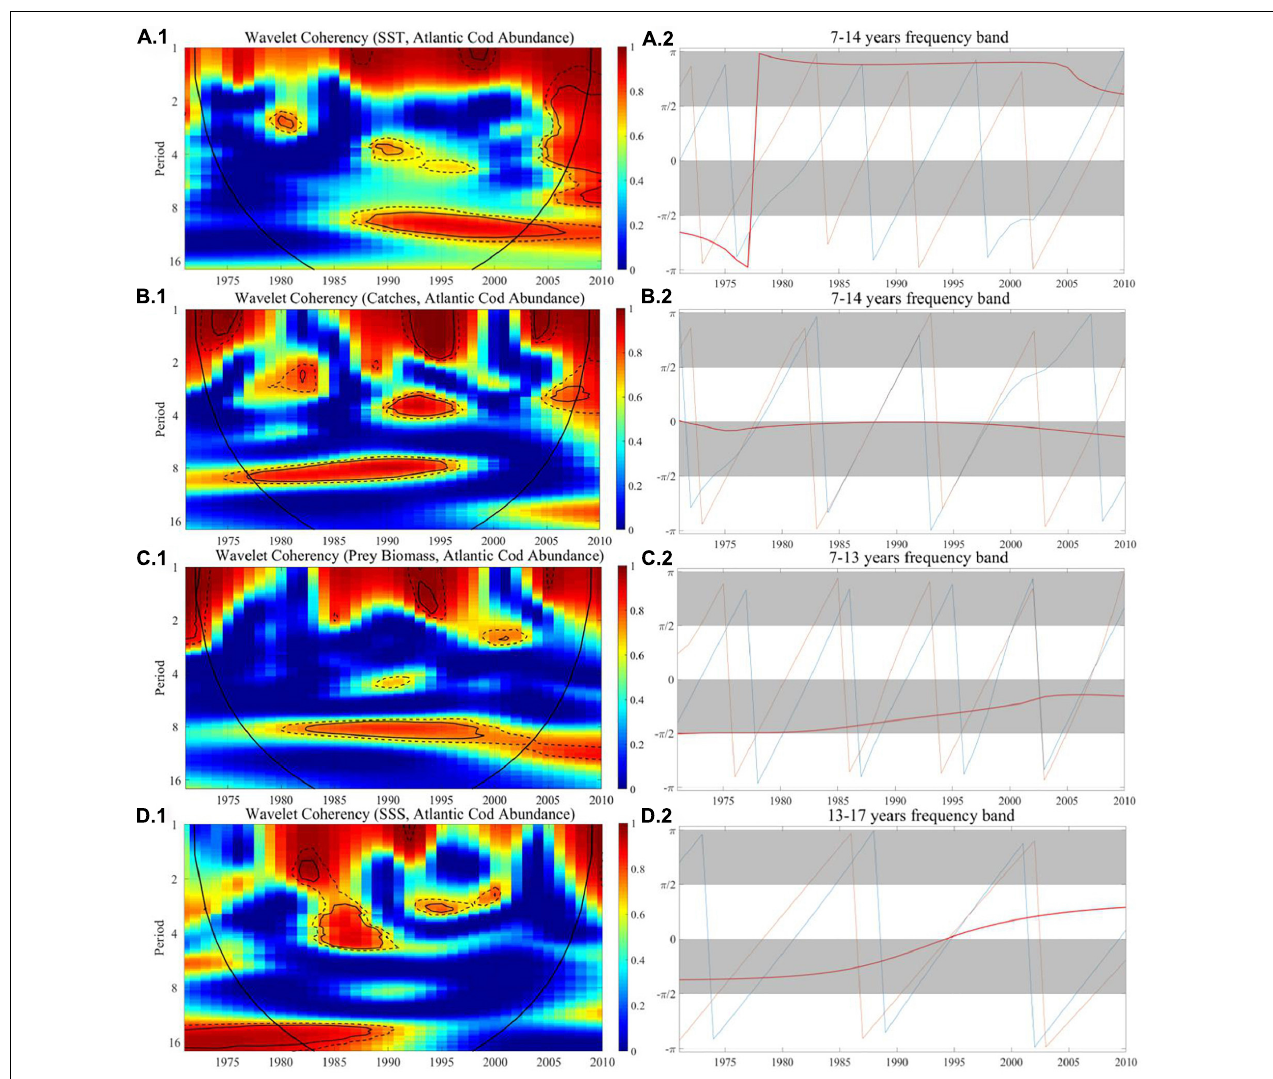
FIGURE 6 | The wavelet coherence and phase difference between Atlantic cod abundance and SST, catches, prey biomass, and SSS at site 119. (A–D.1) Wavelet coherence and (A–D.2) phase difference. The y -axis refers to frequency (in years), and the x -axis refers to the time